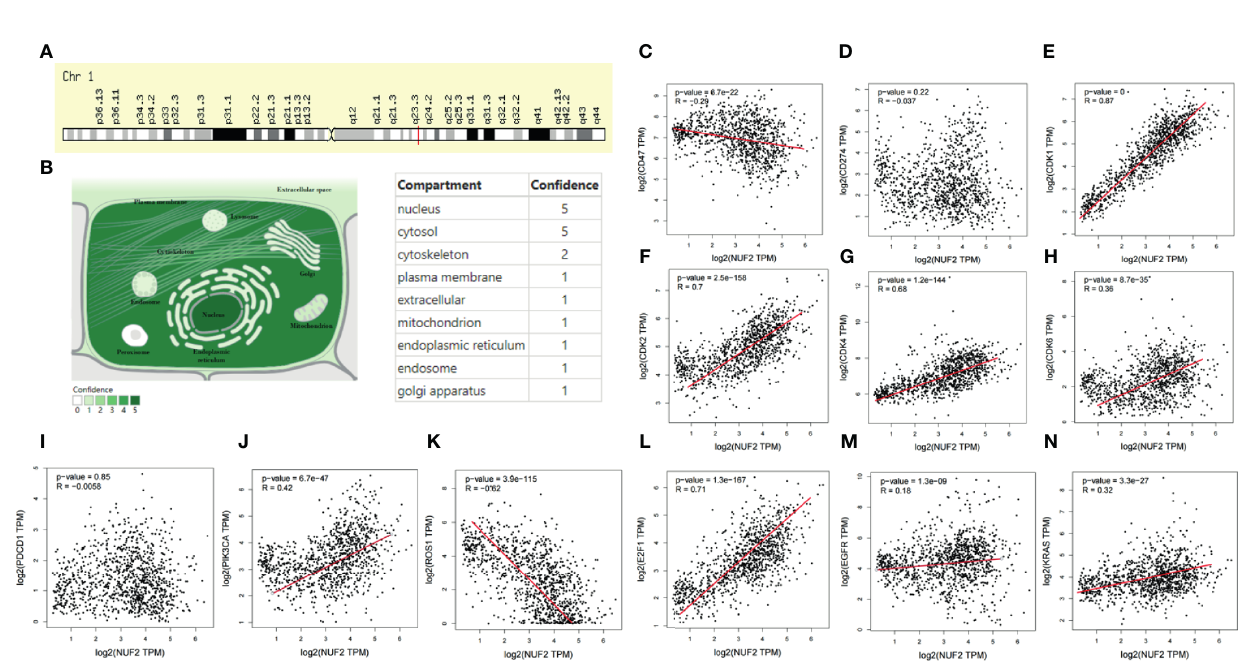
FIGURE 6 | Basic characteristic of NUF2 and the correlation of NUF2 with special genes. (A) Genomic location of NUF2 gene via genecards. (B) Subcellular location and its con fi dence of NUF2 gene from COMPARTMENTS. (C – N) In the GEPIA database, scatterplots correlations of NUF2 with well-known oncogenes and genes related cell